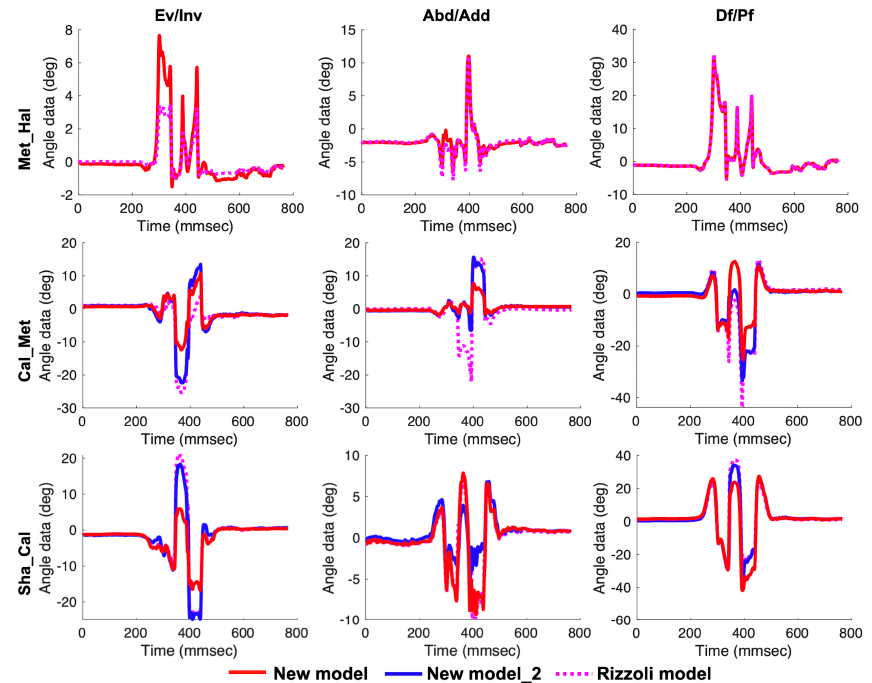
Figure 11. Left to right, the temporal patterns of rotation in the frontal, transverse, and sagittal planes during the drop jump. New model (red solid line), New model_2 (blue solid line), and the Rizzoli model (pink dot line) are shown. First to third row in order, the three joint angles (Met_Hal, Cal_Met, and Sha_Cal) are shown.